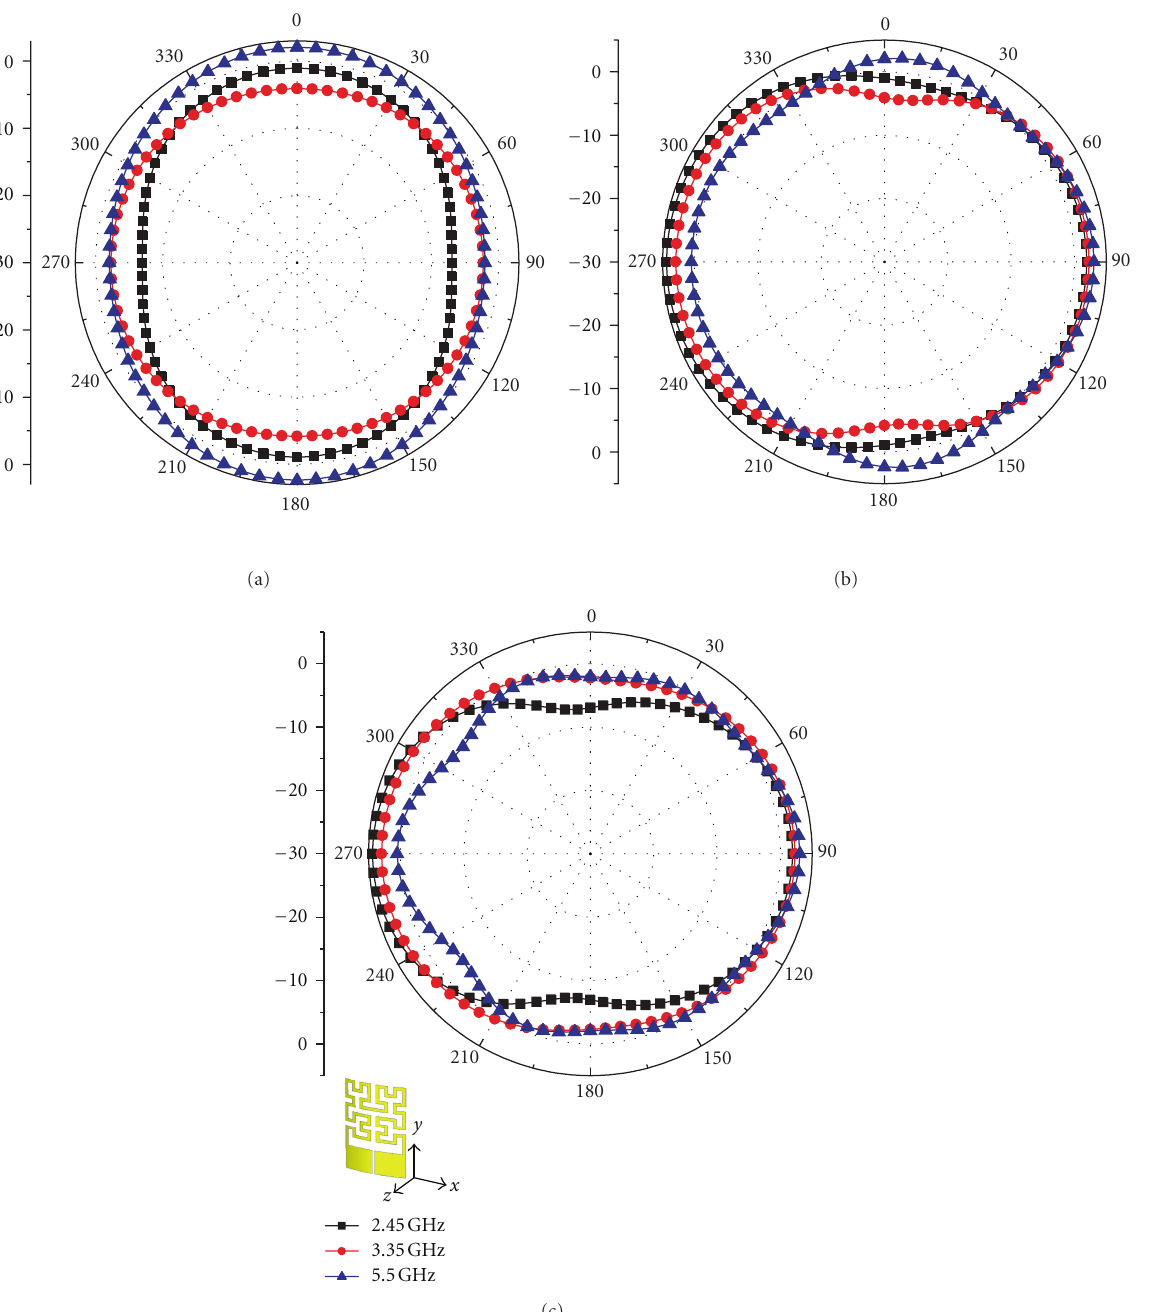
Figure 6: Simulated radiation patterns of the proposed antenna at 2.45/3.35/5.5 GHz. (a) xz -plane, (b) yz -plane, and (c) xy